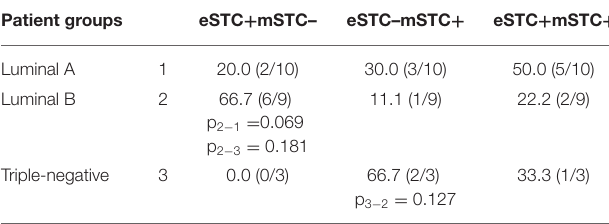
TABLE 3 | Frequency of eSTCs and mSTCs in different molecular subtypes of breast cancer. Patient groups